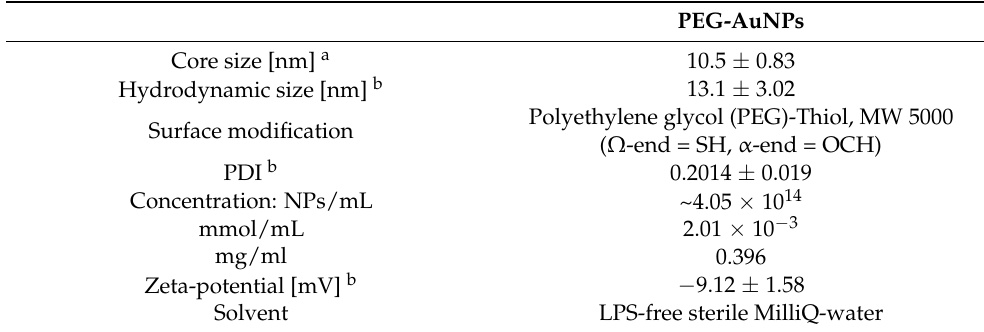
Table 1. Main physicochemical parameters of